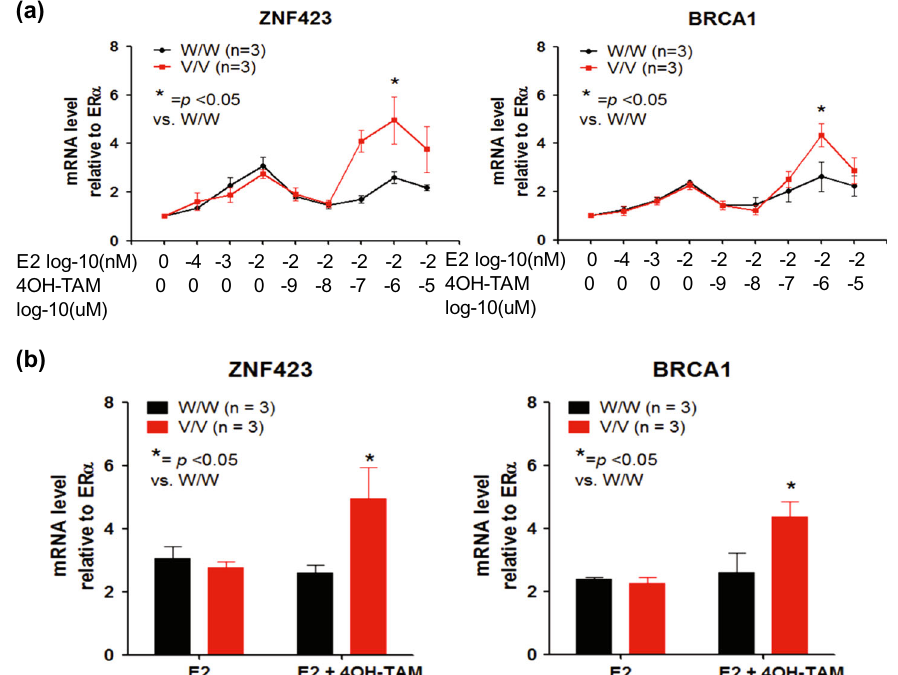
Fig. 4 The induction of ZNF423 and BRCA1 mRNA expression in a SNP-dependent, SERM-dependent fashion for LCLs homozygous for WT and variant ZNF423 rs746157 and rs12918288 genotypes. a The fi gure shows the effect of E2 and E2 plus 4OH-TAM dose response curves on the expression for ZNF423 and BRCA1 in LCLs homozygous for WT and variant genotypes for the rs746157 and rs12918280 SNPs in ZNF423 intron 5. Values are mean ± SEM for 3 determinations. All of these LCLs were homozygous WT for the intron 2 rs9940645 SNP. b Bar graphs showing mRNA expression for ZNF423 and BRCA1 at the optimal concentrations for E2 (0.01 nM) and E2 (0.01 nM) plus 4OH-TAM (0.01 μ M) shown in ( a ). Compare with Fig. 1b. Data represented as mean ±